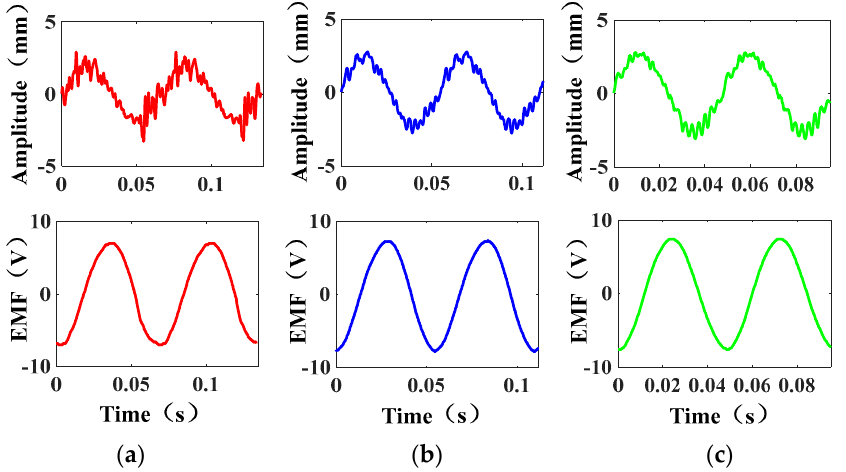
Figure 16. Effect of the excitation frequency on the EMF:( a ) 15 Hz; ( b ) 18 Hz; ( c ) 21Hz. According to the experimental results, the peak values of the output EMF are 7 V,